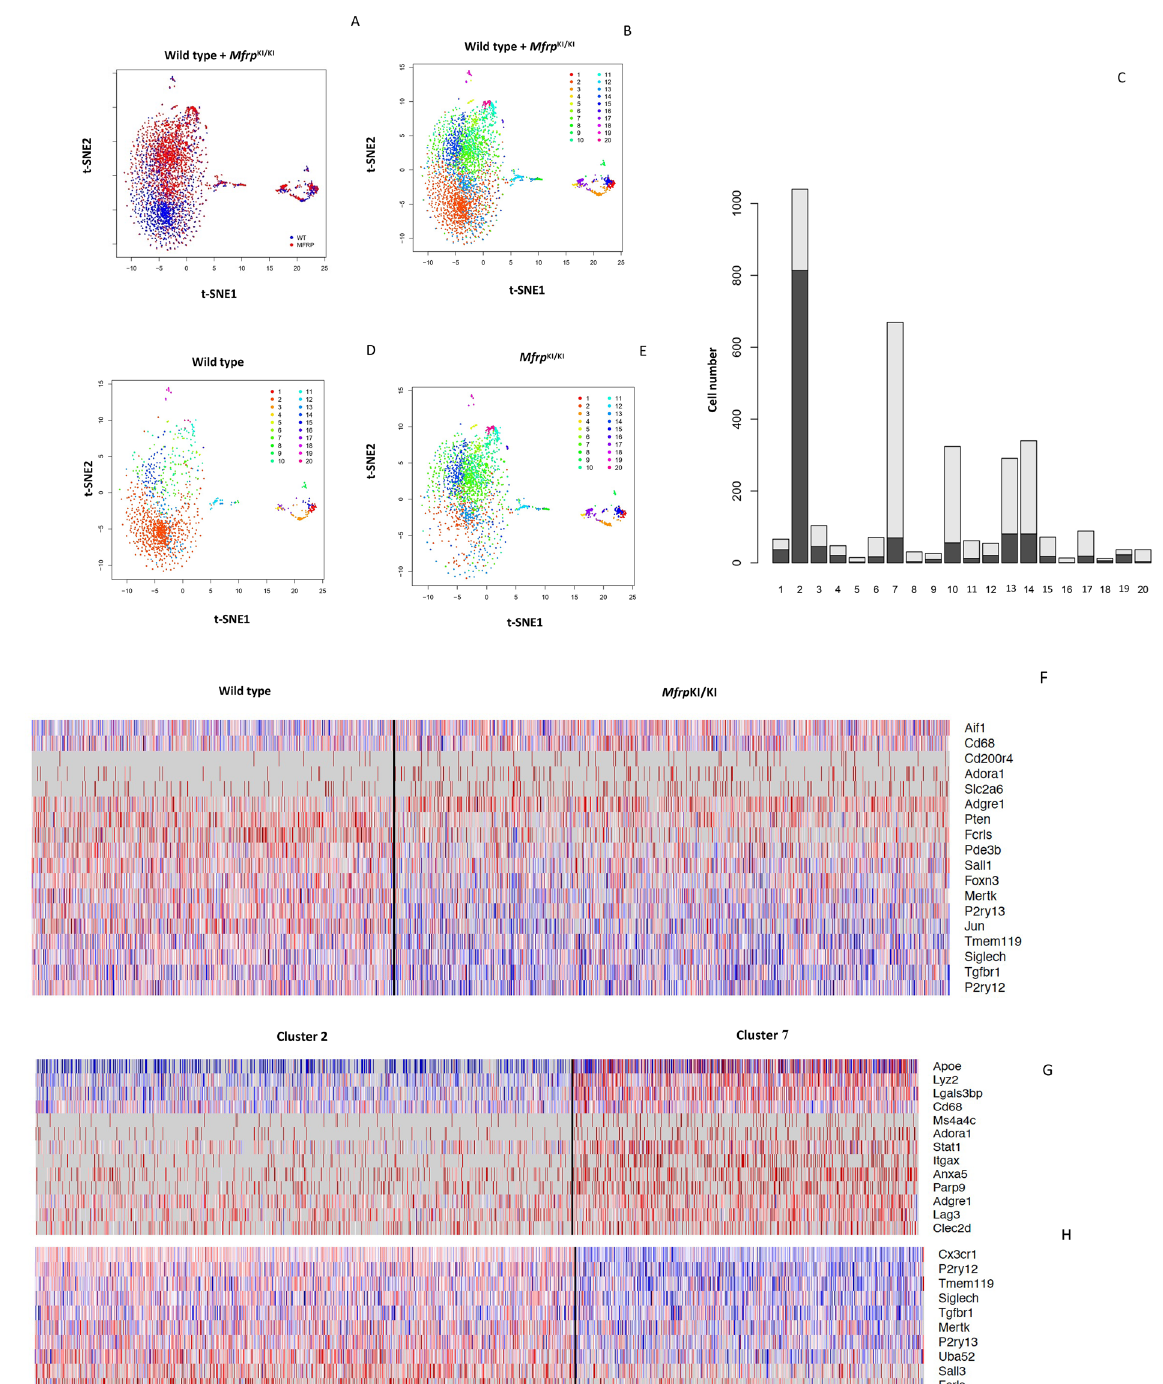
Figure 5. Single cell RNA sequencing analysis. tSNE plots and clustering of microglia from WT (1345 Cells) and Mfrp KI /KI (2059 cells) retina. ( A ) tSNE plot of microglia from WT and Mfrp KI /KI mouse retina. ( B ) tSNE plot dividing microglia from WT and Mfrp KI /KI mouse retina into clusters. ( C ) Histogram representing microglia divided into clusters from both groups, (Black-WT cells, Gray- Mfrp KI /KI . ( D ) WT mouse retina microglia tSNE plot with clusters. ( E ) Mfrp KI /KI mouse retina microglia tSNE plot with clusters. Heat maps of generated by “pheatmap” package in R program. ( F ) Differentially expressed microglial markers in WT and Mfrp KI /KI mice. ( G ) Microglial activation, ( H ) homeostatic markers after comparing cluster 2 and 7 (Blue = Downregulation, Red = upregulation). ( I ) Violin plots showing expression of CD68 , F4/80 , ApoE (microglial activation markers) Siglech, Tmem119, P2ry12 (homeostatic markers) lfdr <